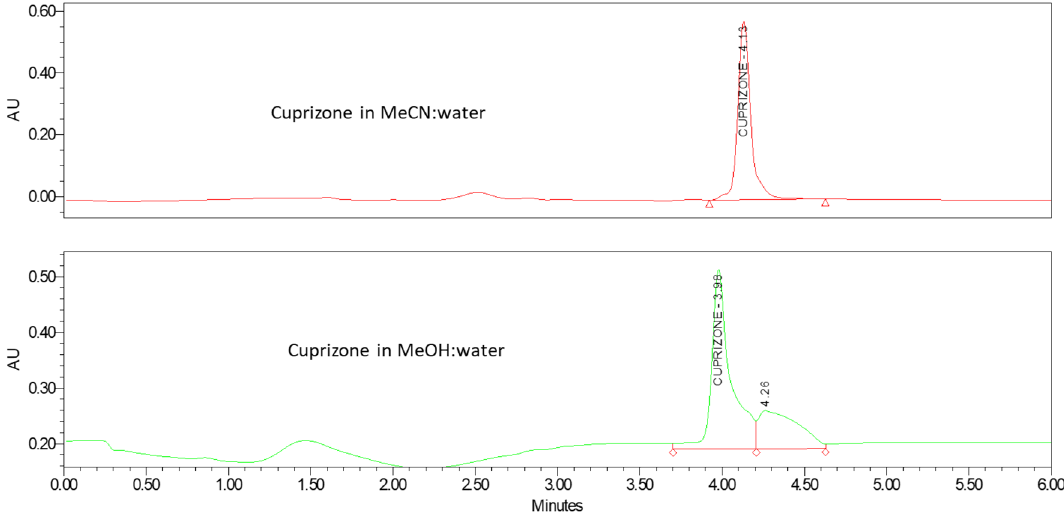
Figure 5. HPLC chromatograms for cuprizone reference standards, Xbridge HILIC column, (top) 1:1 MeCN: water as sample solvent; (bottom) 1:1 MeOH: water as sample solvent. Column tested Column type